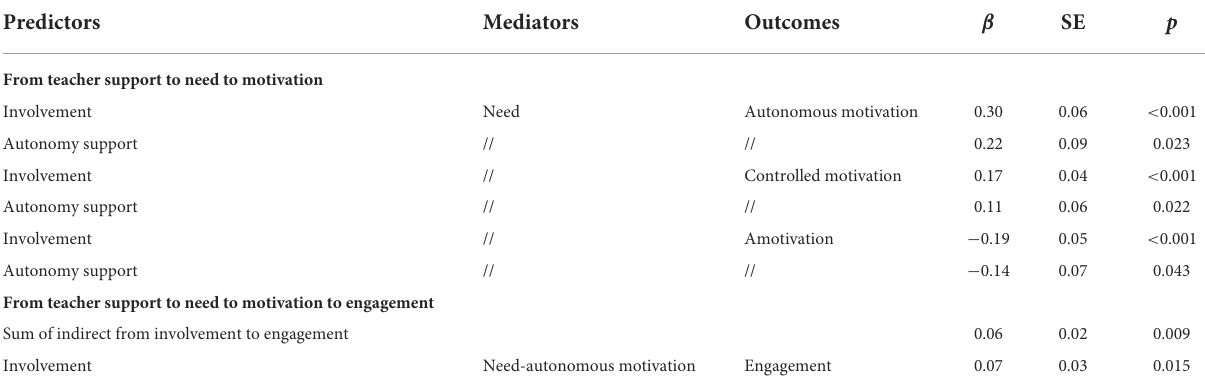
TABLE 4 The significant indirect path coefficients in model